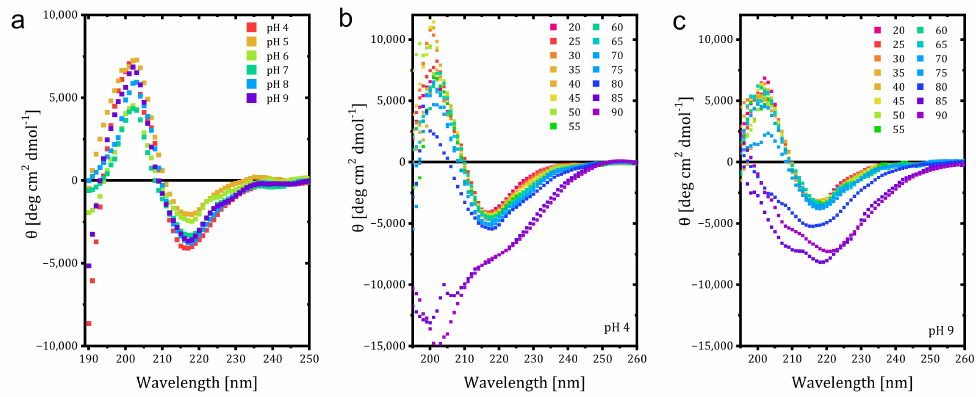
Figure 2. ( a ) MRE values for trastuzumab within different pH at 20 ◦ C. ( b ) Temperature-ramped CD spectrum of trastuzumab at pH 4 and ( c ) pH